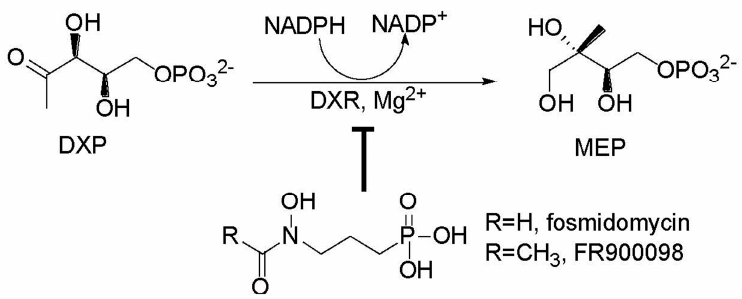
Figure 1. The first committed step of the 2-methyl-D-erythritol-4-phosphate (MEP) terpenoid biosynthetic pathway and its inhibitors.